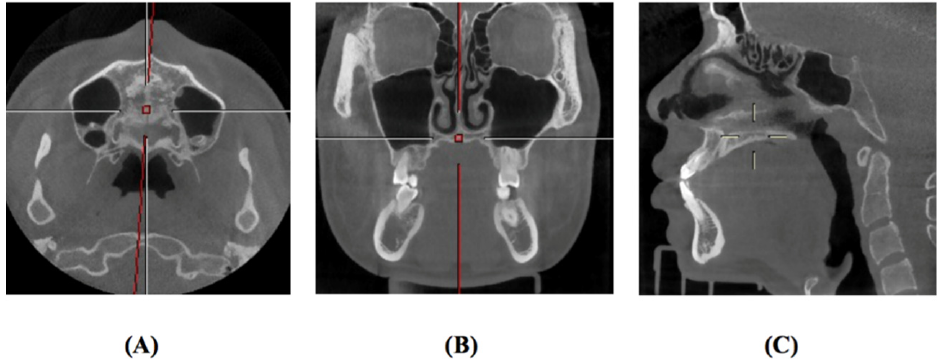
Figure 1. Head orientation in CBCT examination. ( A ): Axial view; ( B ): Coronal view; ( C ): Sagittal view.